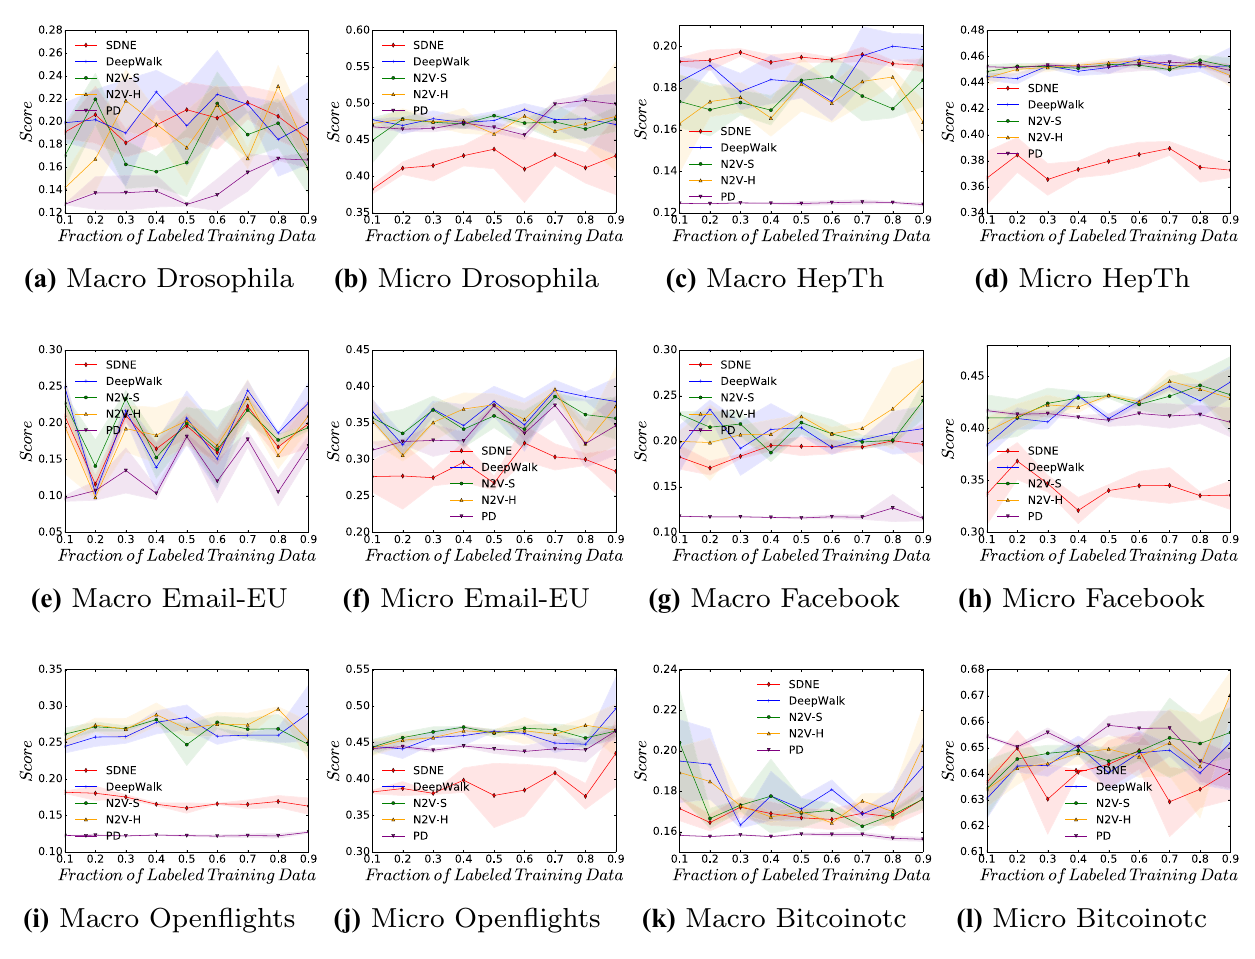
Fig. 3 Micro- and macro-f1 scores, across a range of labelling fractions, for all approaches when predicting a vertex’s degree centrality (DG) value across all